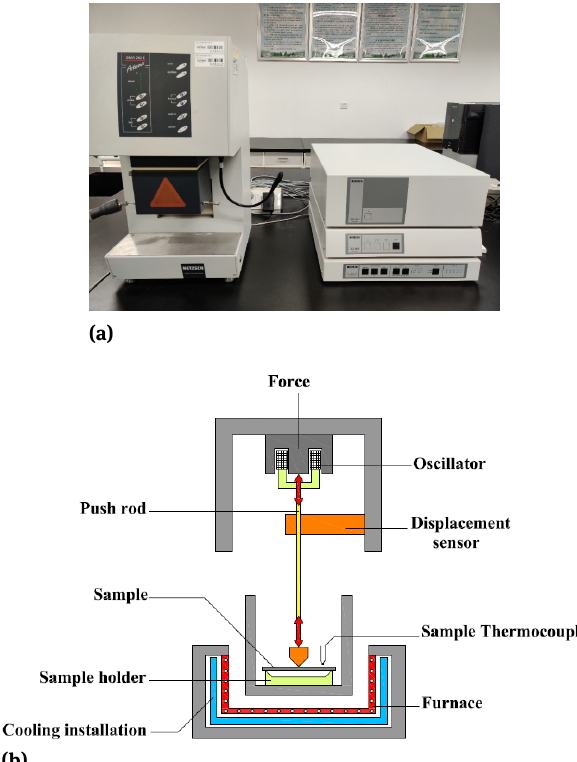
Figure 3: (a) DMA instrument diagram; (b) DMA